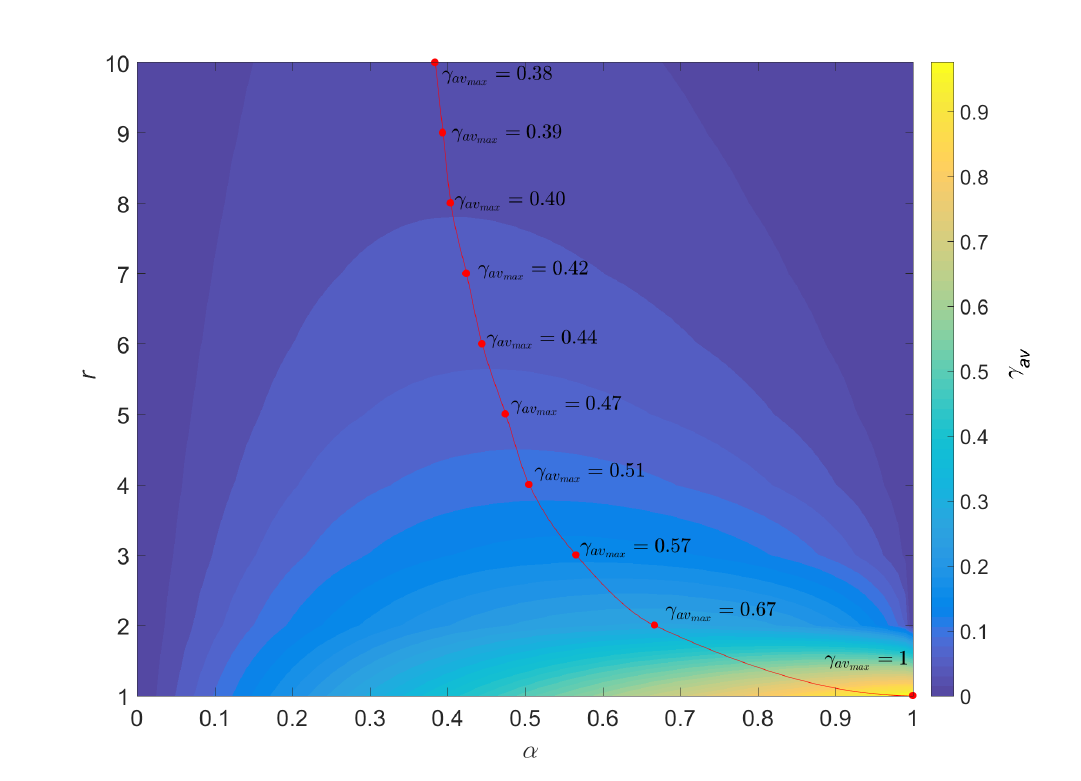
Figure 3. Locus of γ av versus ( α , r ) and the points with maximum value γ av = max ( γ av ) .